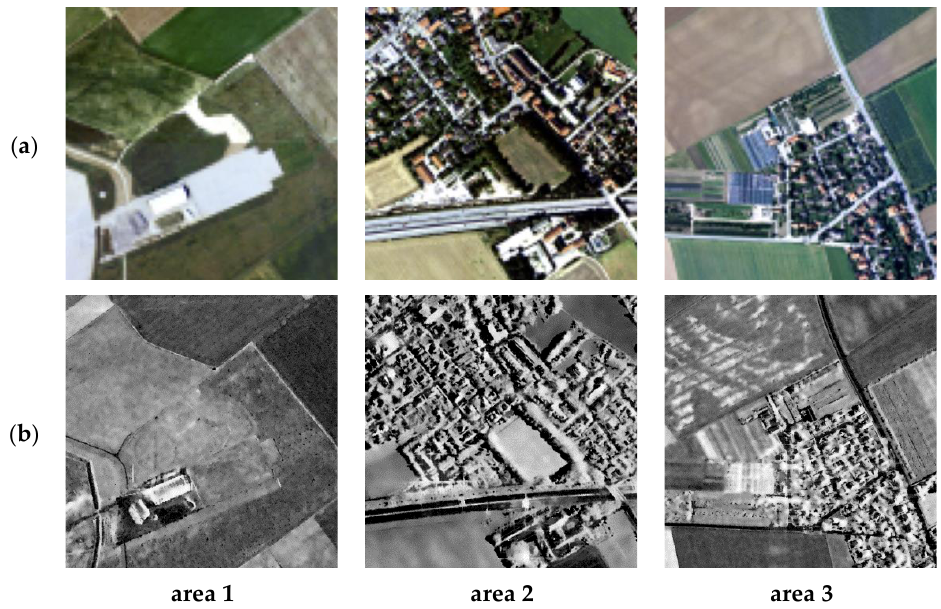
Figure 3. Multispectral and SAR images used for fusion experiments, located in the Trudering region of Munich in Germany. ( a ) Airborne multispectral images; ( b ) airborne SAR intensity images.